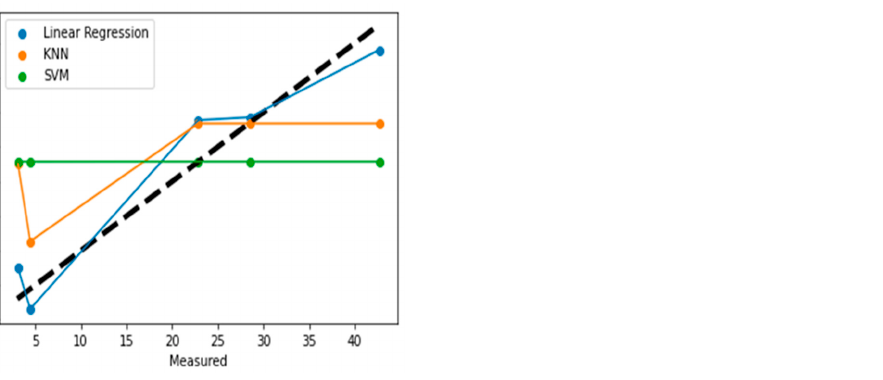
Figure 6. Measured vs. Prediction values for different machine learning algorithms with perfect fit represented as dotted black line.